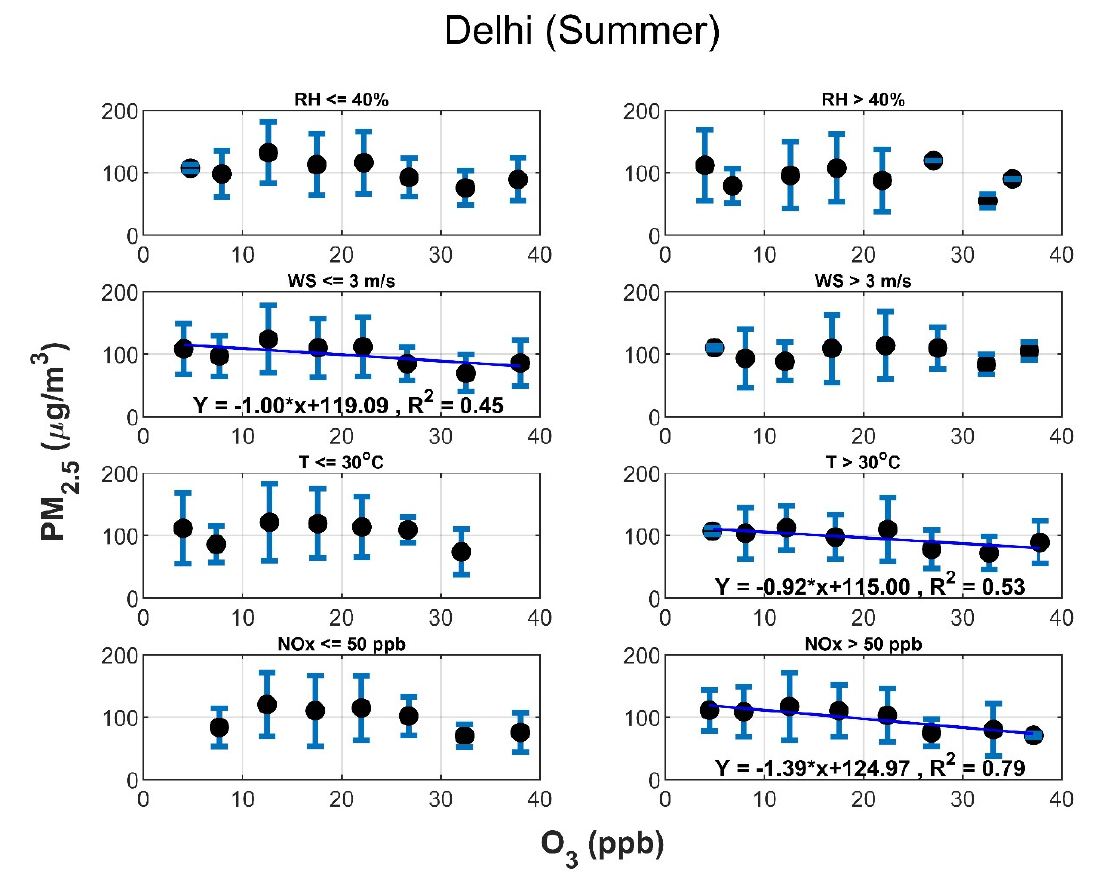
Figure 7. Dependence of PM 2.5 concentrations on O 3 in Delhi during the summer season for different meteorological parameters.